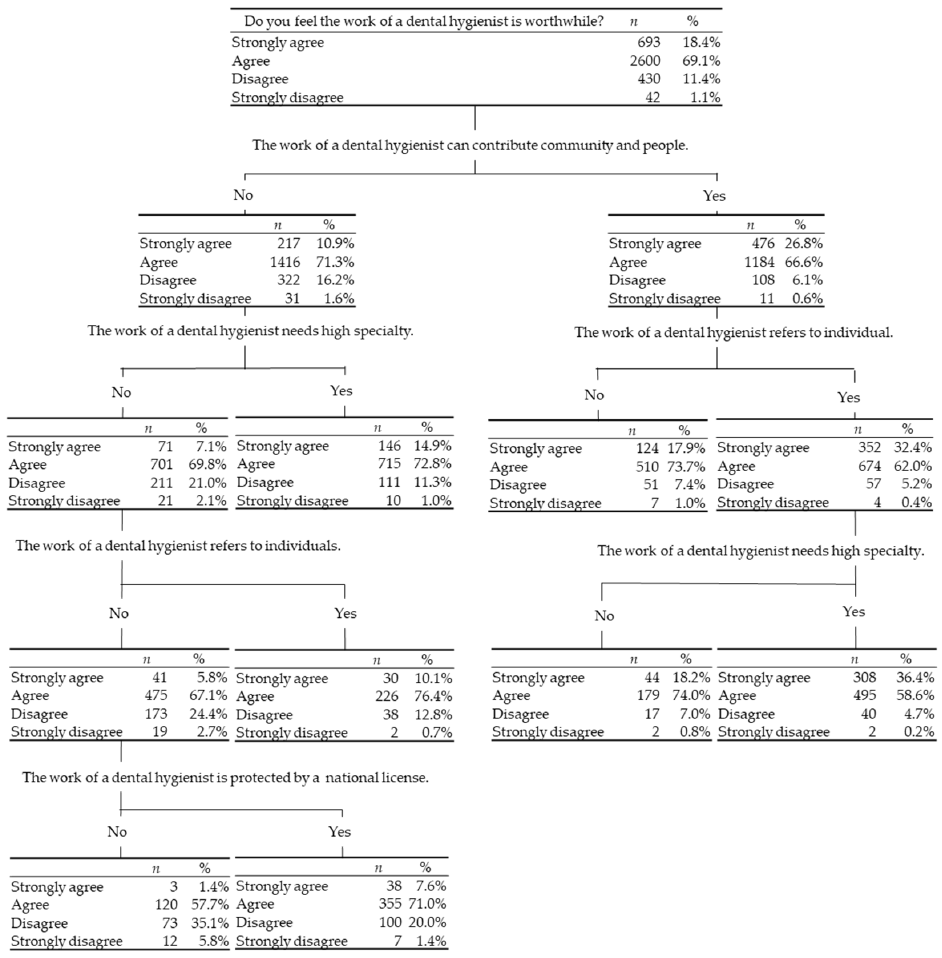
Figure 3. Decision analysis to determine the dental hygienists who answered “strongly disagree” to “Do you feel that dental hygienist work is rewarding?” Similarly, 218 dental hygienists did not wish to continue their work. Among them,